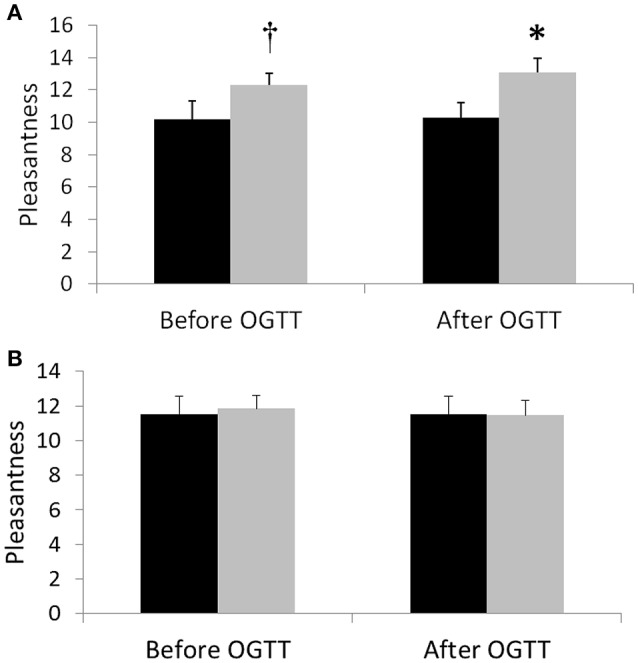
Pleasantness 1 day after the SitLess (gray) and Sit (black) regimens in women (A) and men (B). Pleasantness was measured before (−60 min) and 190 min after administering an oral glucose drink (OGTT). *p < 0.05; †p = 0.059.